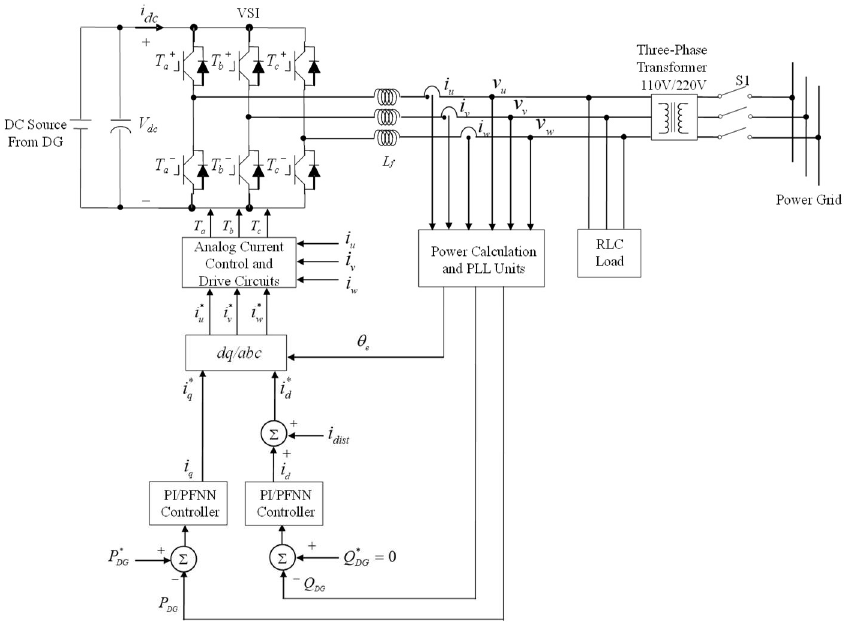
Figure 1. Circuit architecture of the inverter-based DG system.